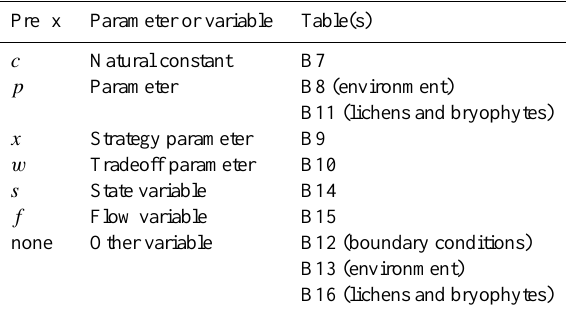
Table B1. Overview of the nomenclature of parameters and vari- ables in the